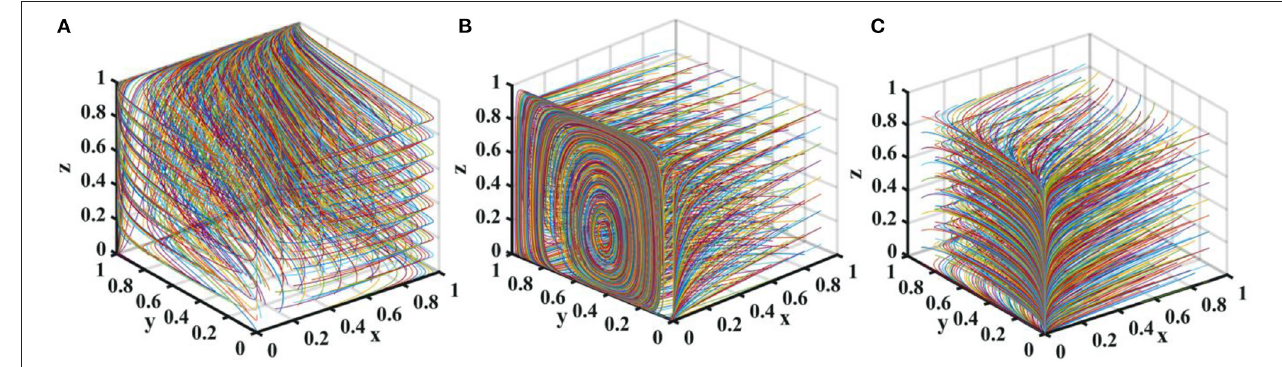
FIGURE 8 | Impact of additional costs on the evolution of each player’s strategy. Figure is the simulation diagram that shows the influence of the additional costs on the strategic choices of local government, drug enterprises, and third-party testing agencies. (A) When the situation G k − G l = 0.0, C k − C l = 0.0. (B) When the